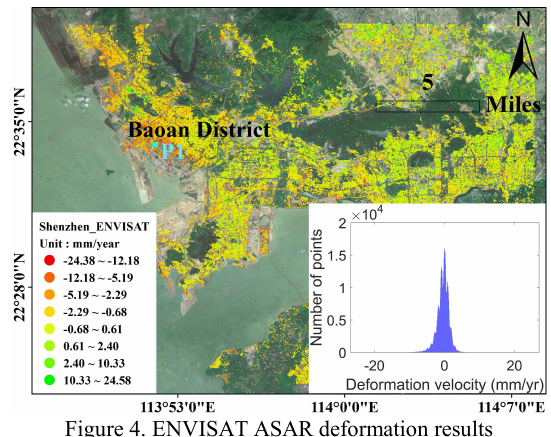
Figure 4. ENVISAT ASAR deformation results